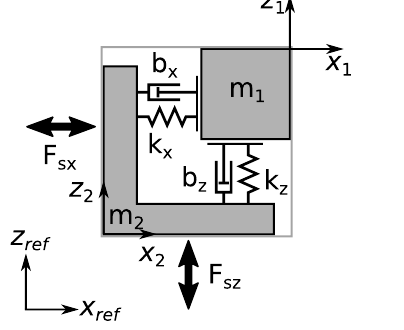
Figure 10. Two-dimensional representation of the dual-mass oscil- lator for multi-component force sensors.